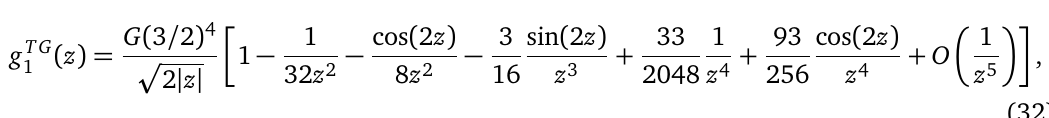
Figure 5: Dimensionless correlation functions g g from Ref. [ 107 ] (black, dashed) as functions of the dimensionless interaction strength γ . 3 Three-body processes are strongly suppressed at high interaction strength but become of the same order of magnitude as two-body processes in the quasi-condensate